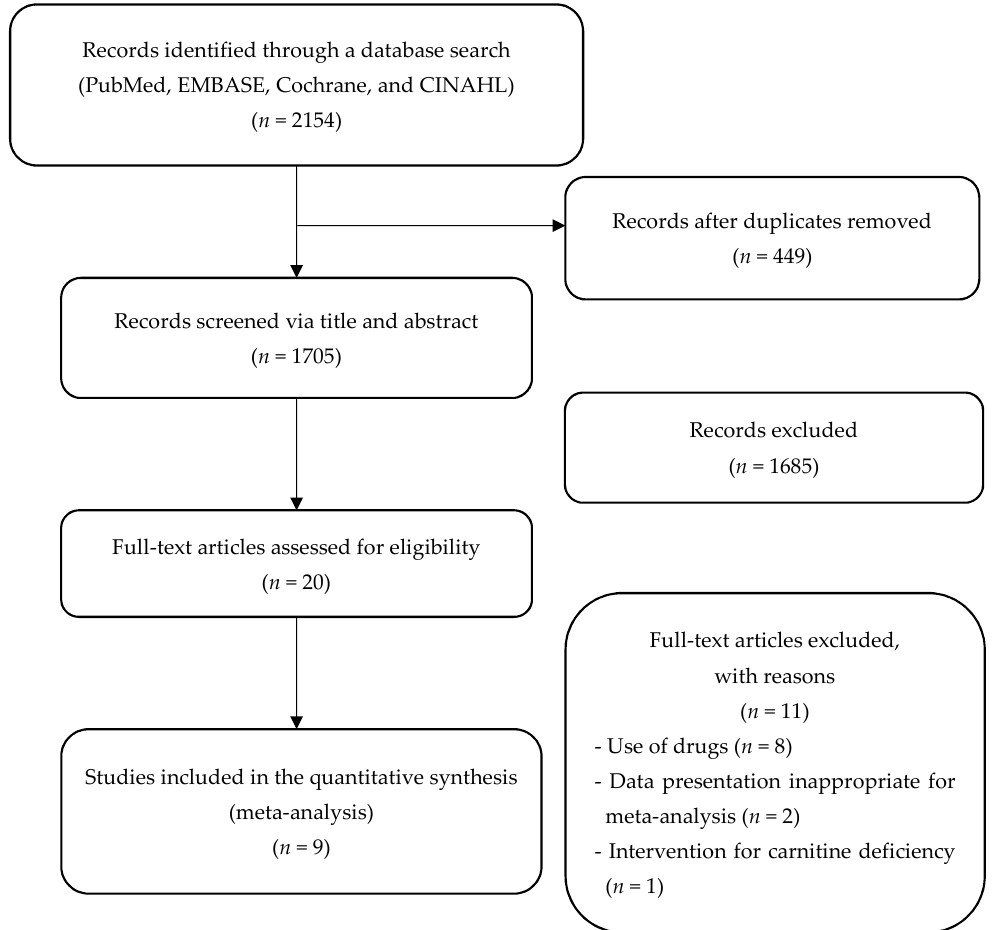
Figure 1. Flow chart of the study selection